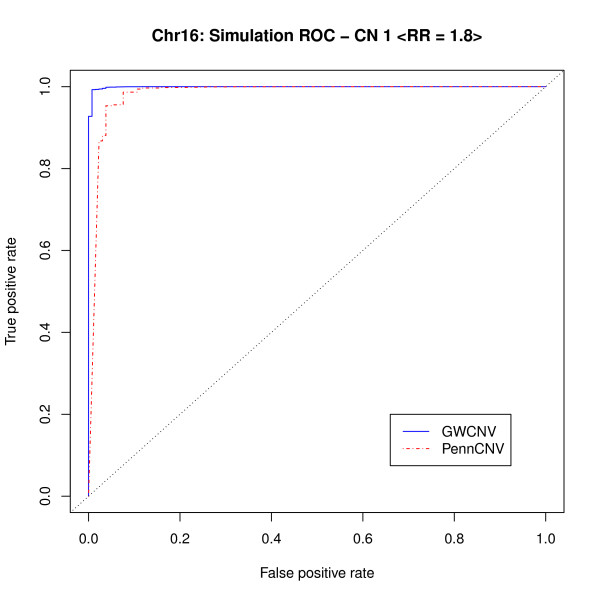
ROC curve for simulated strong signals (RR1 = 1.8).